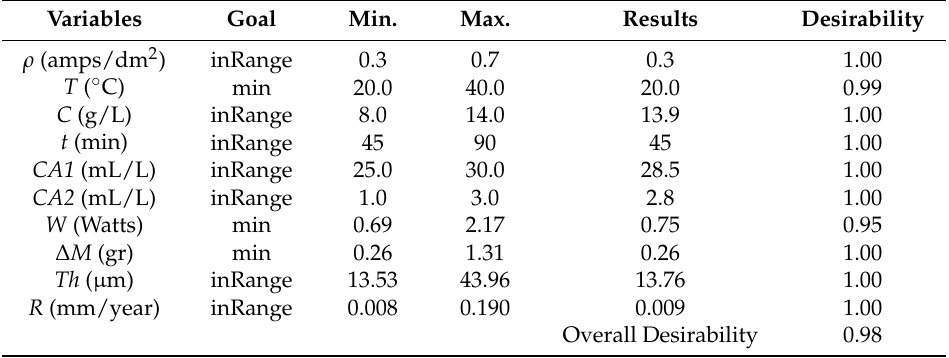
Table 10. The first criterion that was considered: coating process cost based on minimizing the power consumed ( W ), the temperature ( T ), and the coating mass ( ∆ M ).